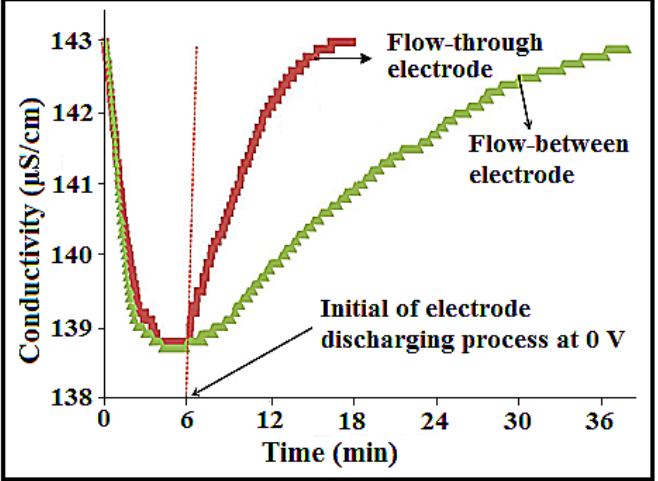
Figure 6. Comparison of NaCl adsorption and the release behaviour of the 23.58 wt% a-SWCNT-coated RVC electrode when configured for flow-between and flow-through systems in a CDI cell measured at a flow rate of 50 mL/min, 75 ppm NaCl, and 1.5